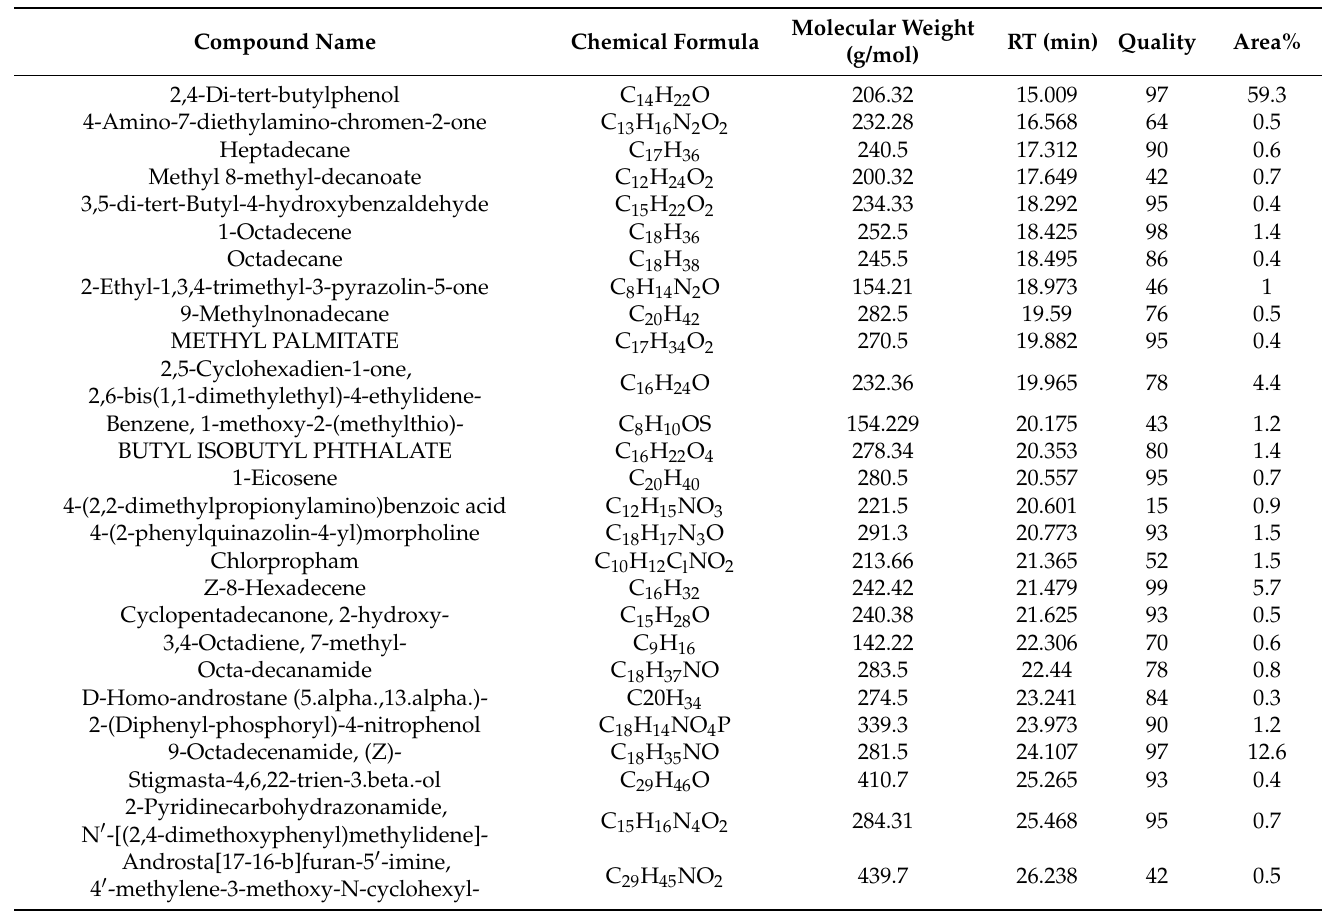
Table 2. The GC-MS analysis of the crude ethyl acetate obtained from mycelia-free medium that used to cultivation of ascospores of T . nivea